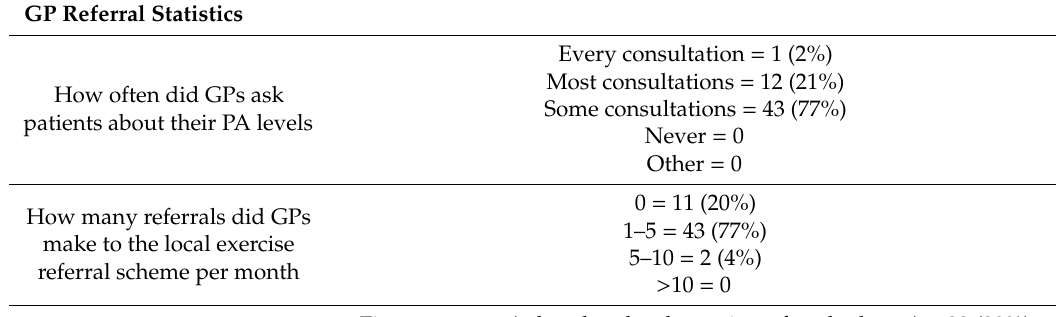
Table 2. GP survey responses ( n = 56) regarding physical activity promotion in Liverpool,